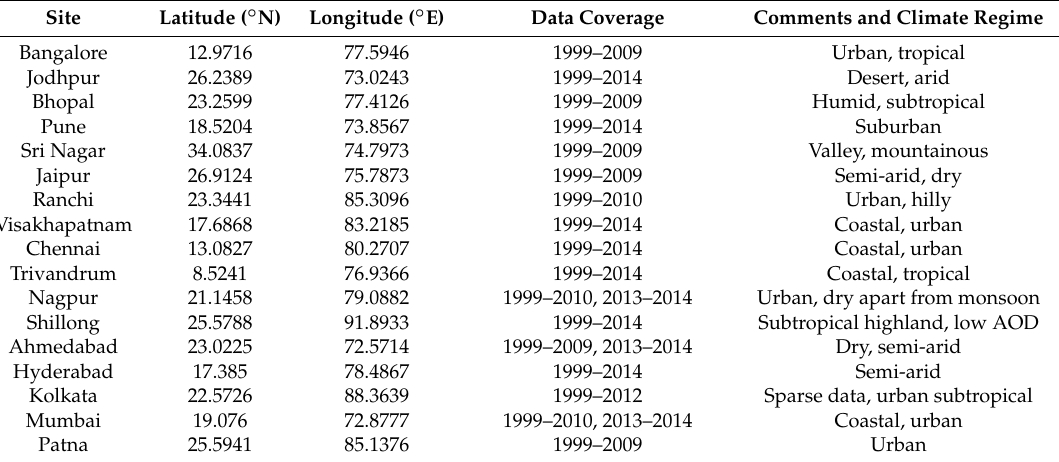
Table 1. Characteristics of the India Meteorological Department (IMD) sites measuring Surface Solar Radiation